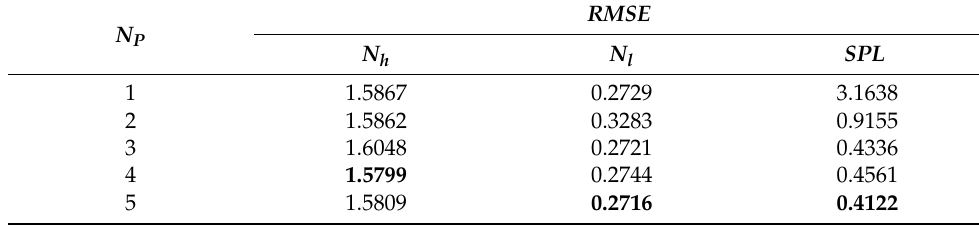
Table 1. Control errors at different prediction horizons.